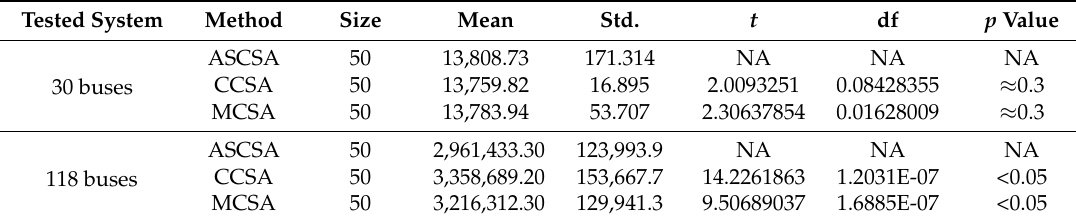
Table 6. The p values of Welch’s t -test for pairwise comparisons.